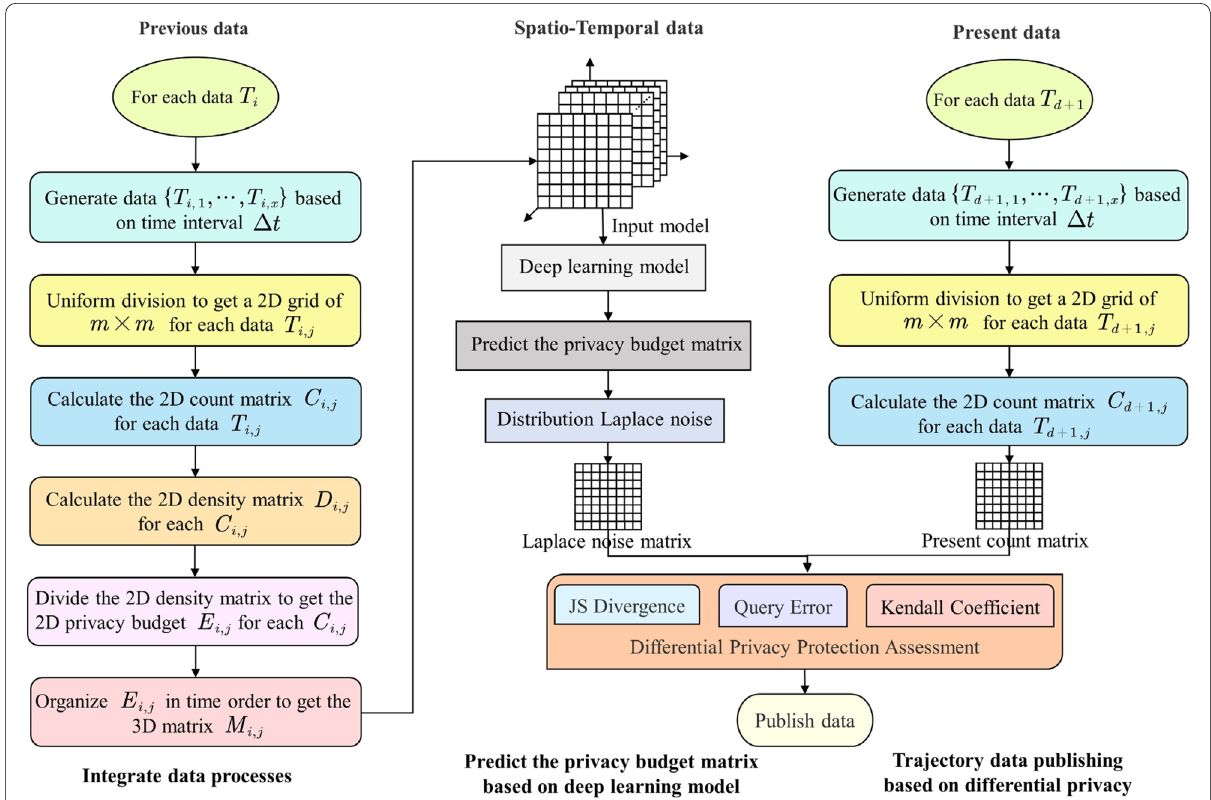
Fig. 4 Differential privacy data publishing process by top-down division and deep